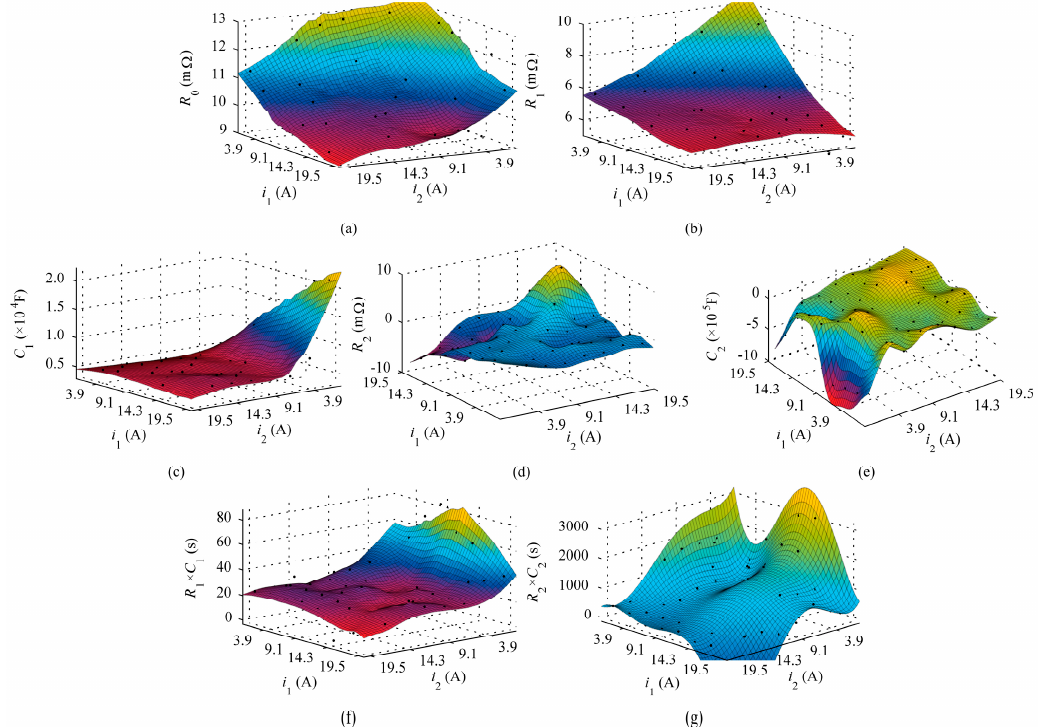
Figure 8. Identified ( a ) R 0 ; ( b ) R 1 ; ( c ) C 1 ; ( d ) R 2 ; ( e ) C 2 ; ( f ) R 1 × C 1 and ( g ) R 2 × C 2 under different sets of { i 1 , i 2 } with the SOC j as 80%.